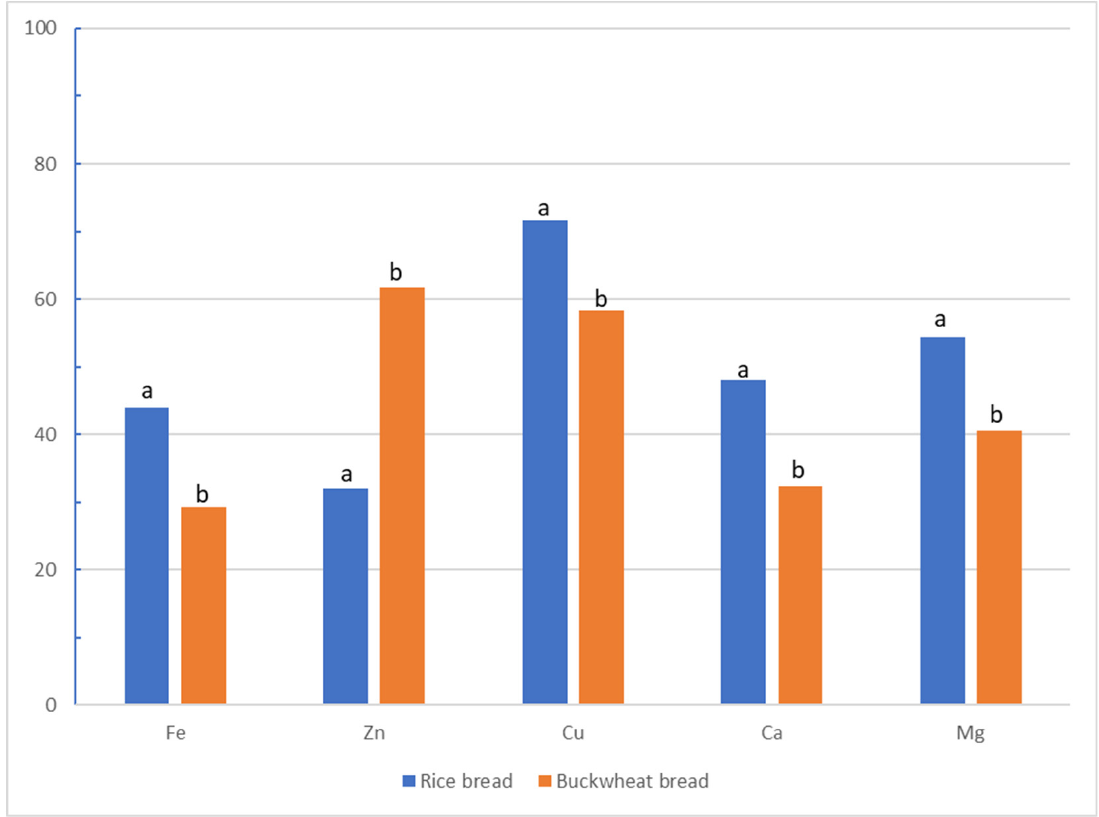
Figure 3. Effects of the type of bread (rice, buckwheat) on the bioavailability of minerals (ANOVA main effects) (%), a, b statistical differences between additives (seeds, supplements).